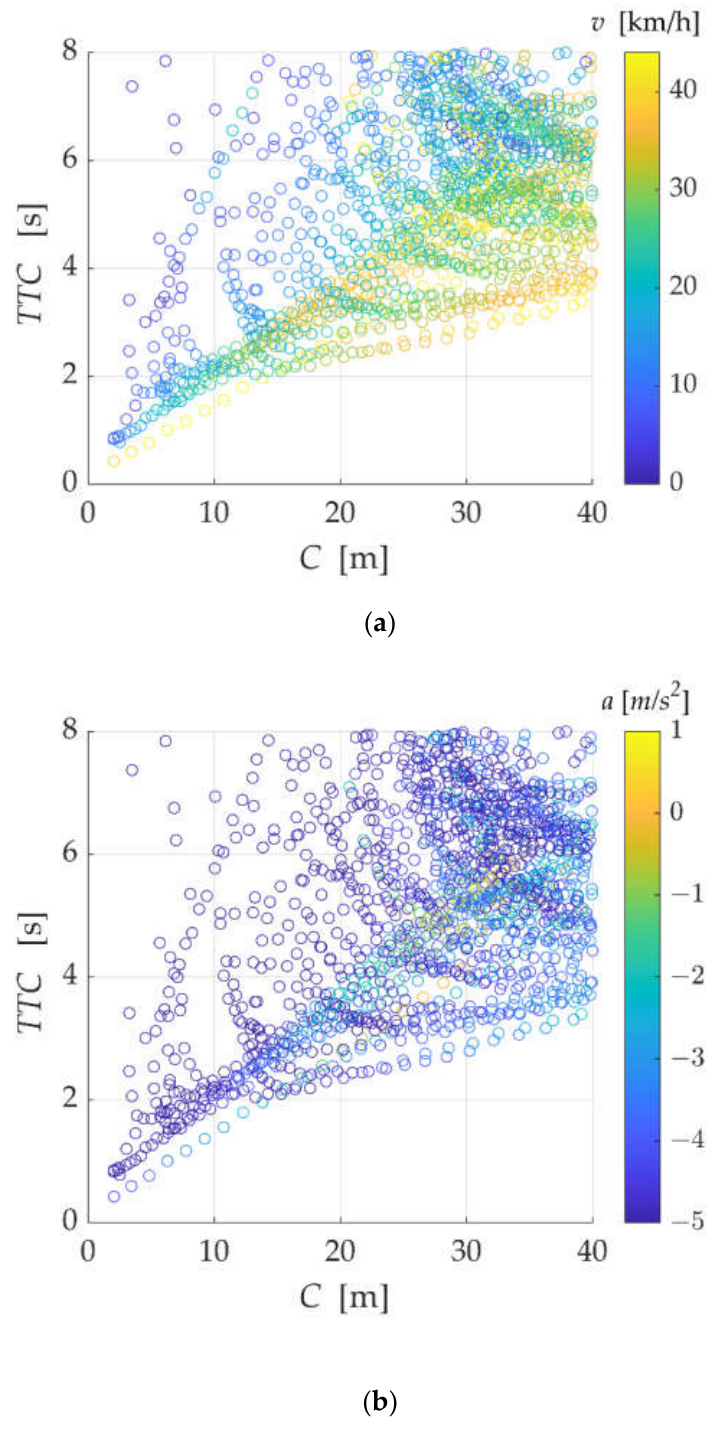
Figure 10. Safety index distribution of the base algorithm. ( a ) Distribution with respect to longitudinal velocity, ( b ) distribution with respect to longitudinal acceleration.